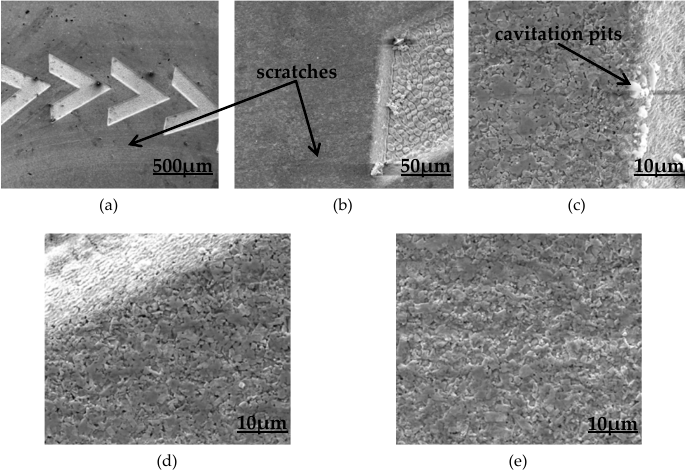
Figure 16. Surface wear morphology of triangular groove textured specimens. ( a ) Triangular groove textured surface wear morphology with a scale of 500 μ m; ( b ) Triangular groove textured surface wear morphology with a scale of 50 μ m; ( c ) Triangular groove textured surface wear morphology with a scale of 10 μ m; ( d ) Triangular groove textured surface wear morphology with a scale of 10 μ m; ( e ) Triangular groove textured surface wear morphology with a scale of 10 μ m.